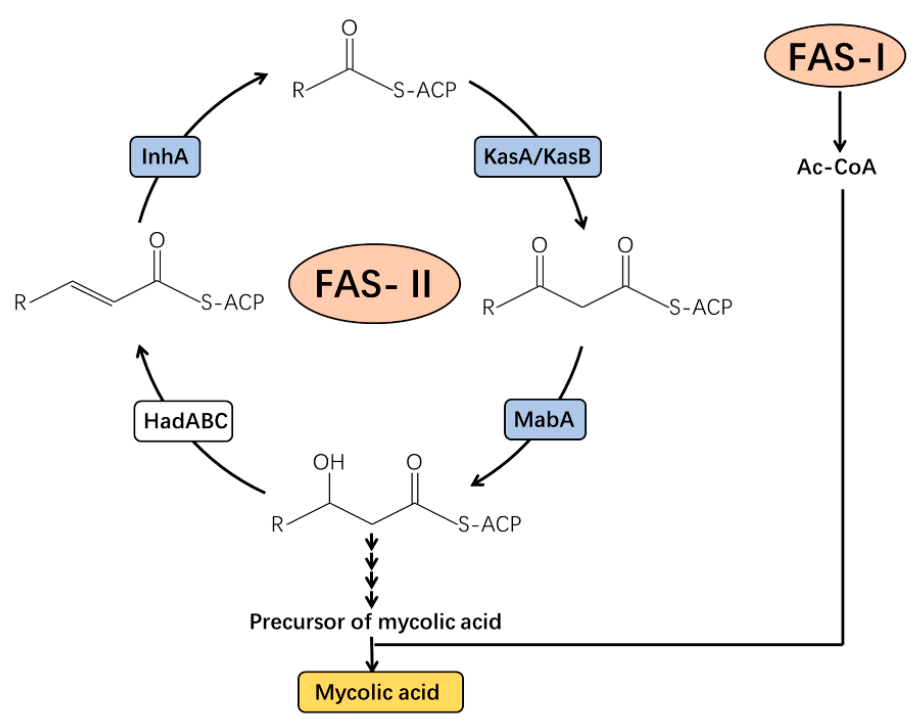
Figure 3. Biosynthesis of mycolic acid in Mycobacteria tuberculosis. Ac-CoA, acetyl-coenzyme A; FAS-I, fatty acid synthase typeI; HadABC, beta-hydroxyacyl-ACP dehydratase complex; InhA, 2- trans -enoyl-acyl carrier protein reductase; KasA/KasB, beta-ketoacyl-acyl carrier protein synthases A/B; MabA, beta-ketoacyl-acyl carrier protein reductase.